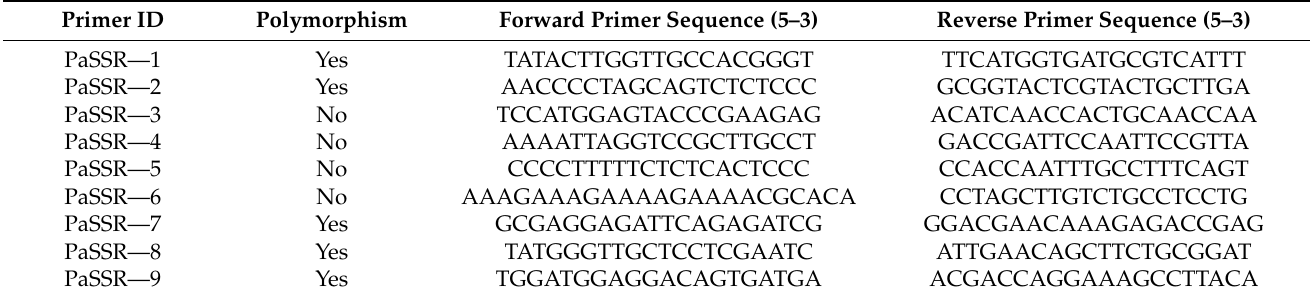
Table 4. The information of 50 pairs of SSR